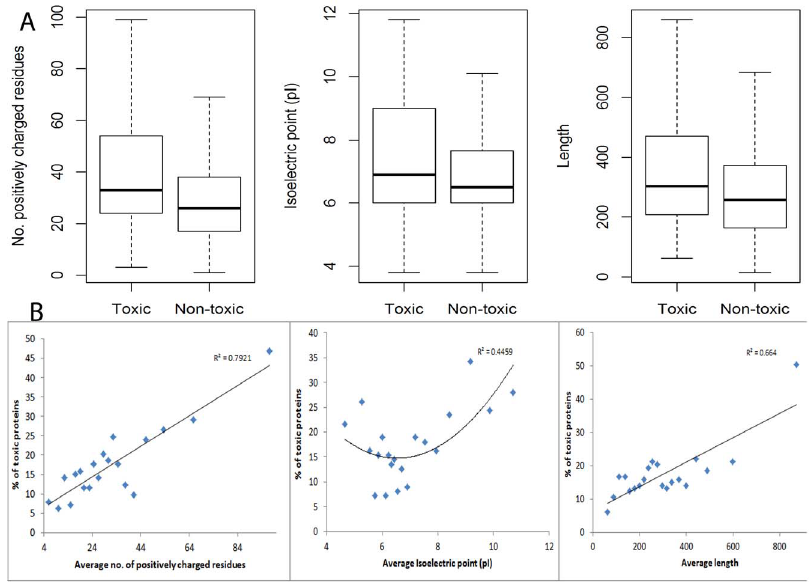
Figure 3. Sequence features associated with toxicity. (A) Toxic proteins have on average higher number of positively charged residues (arginine and lysine), isoelectric point (pI) and length than non-toxic proteins. Wilcox-test p values are 2e-17, 6e-4 and 5e-10 respectively. (B) Proteins are binned into equal sized 20 bins (thus each bin has 5% of proteins) and percentage of proteins which are toxic is plotted for each bin as a function of three sequence features. Linear regression lines are plotted for average positively charged residues and average length and quadratic regression is plotted for pI.